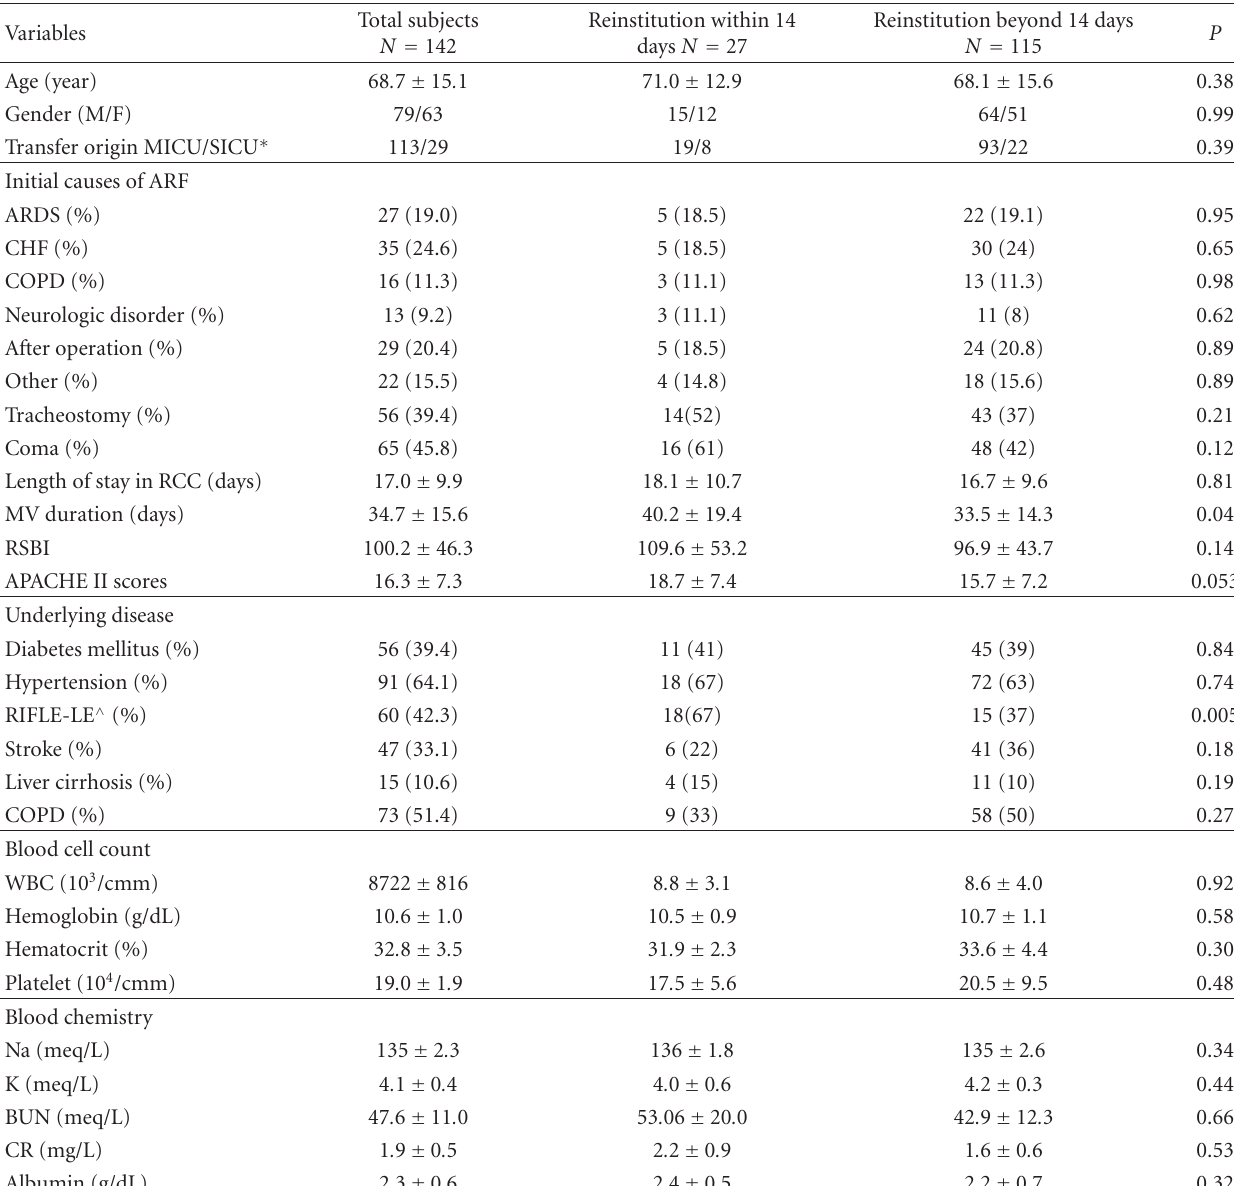
Table 1: Clinical characteristics of 142 prolonged mechanical ventilation patients following weaning and comparison between the reinstitution within 14 days and beyond 14